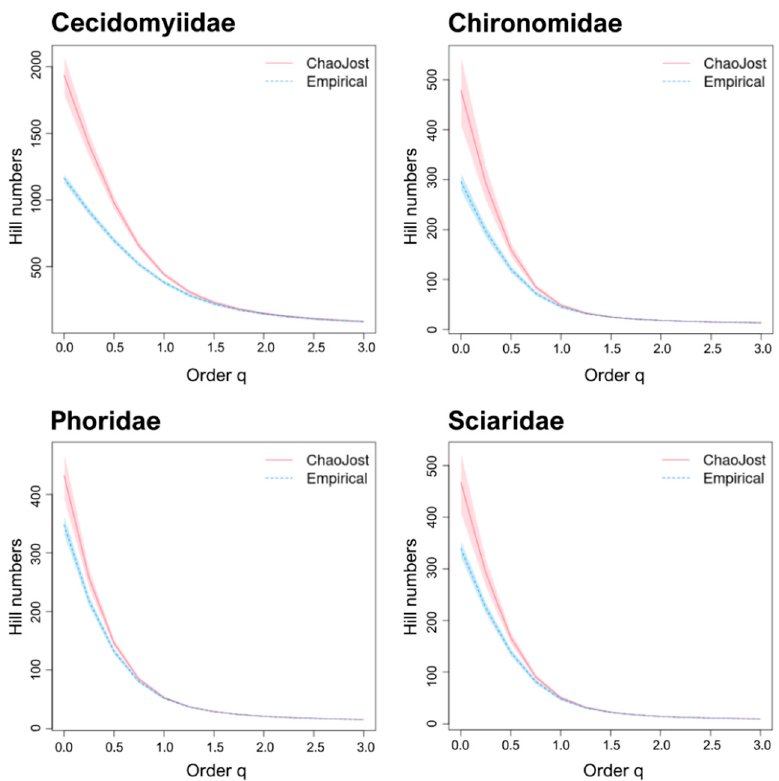
Figure 4. Diversity profiles for the four DT families. The empirical (BIN counts; dotted blue) and estimated (Chao1; red) diversity profiles for communities where Malaise traps were deployed, as quantified by Hill numbers for each of the four “dark taxa” families for values of the diversity order (q) from 0–3 with 95% confidence intervals (shaded areas based on bootstrap analysis of 100 permutations). Species richness is depicted by q = 0; Shannon diversity by q = 1; and Simpson diversity by q = 2.